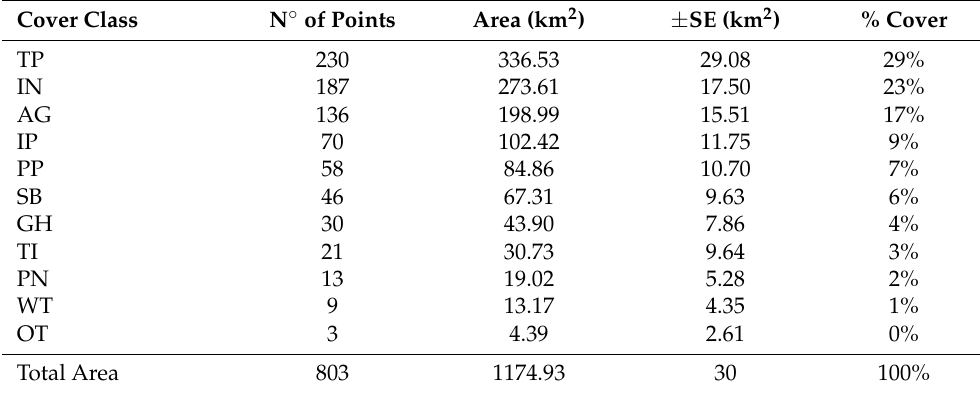
Table 3. Number of points assessed and estimated area for each cover class.